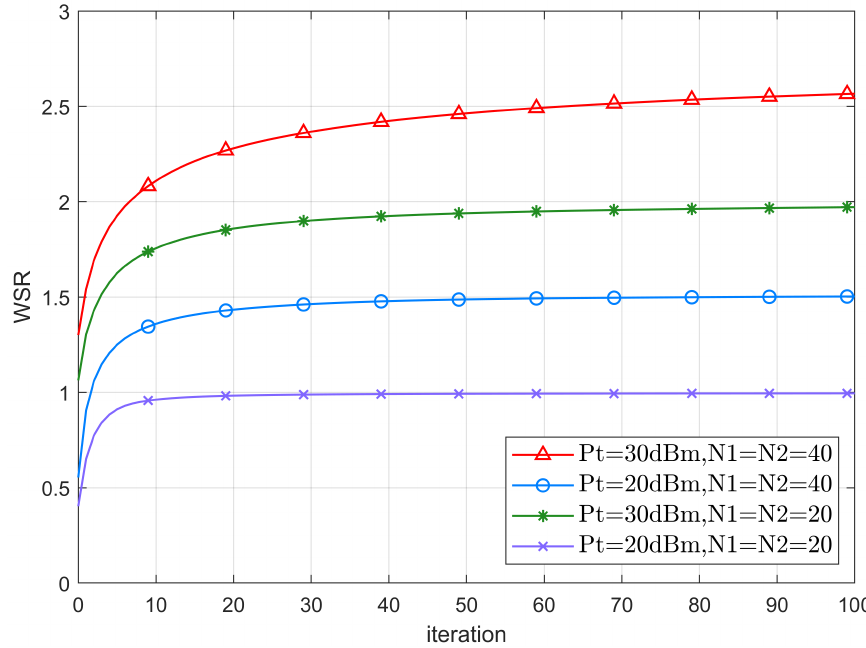
Figure 3. The convergence behavior of the AO algorithm.